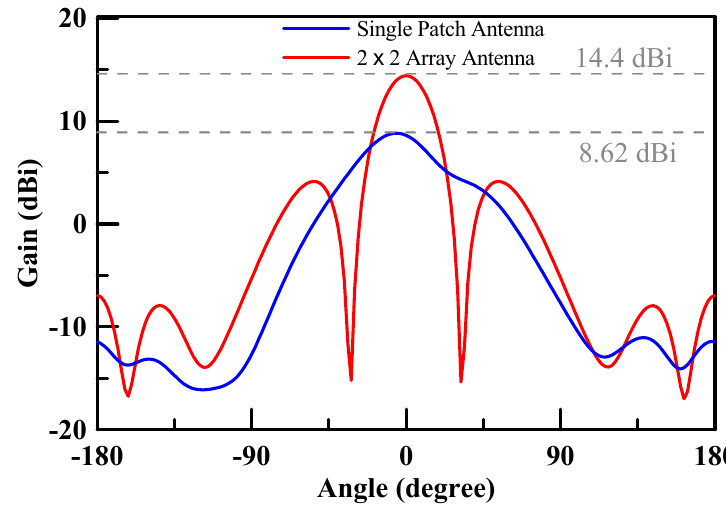
Figure 10. Antenna peak gain.